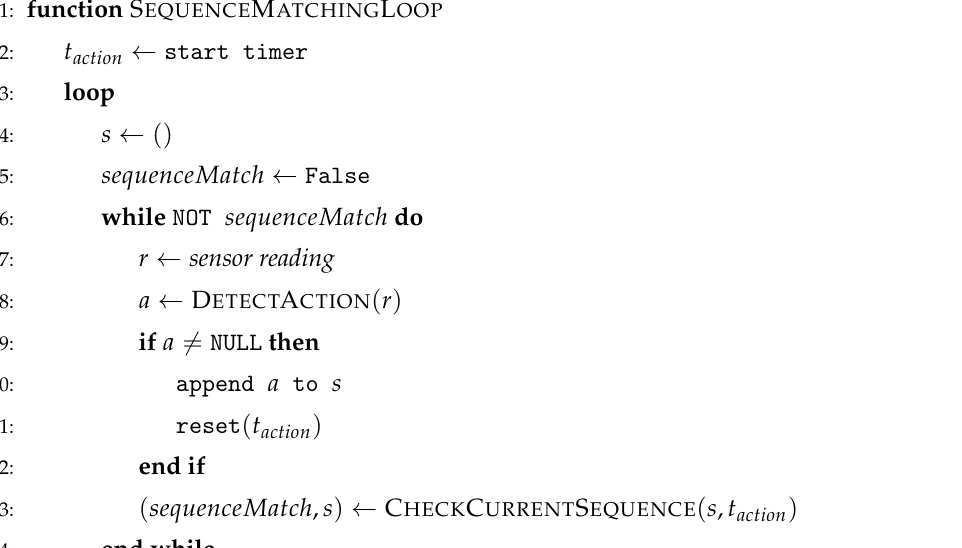
Algorithm 2 General sequence matching